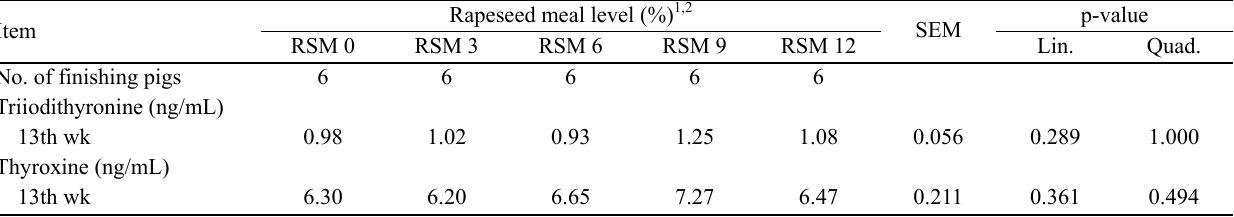
Table 7. Influence of dietary rapeseed meal (RSM) on concentrations of serum triiodithyronine ( T 3 ) and thyroxine ( T 4 ) in finishing pigs Item